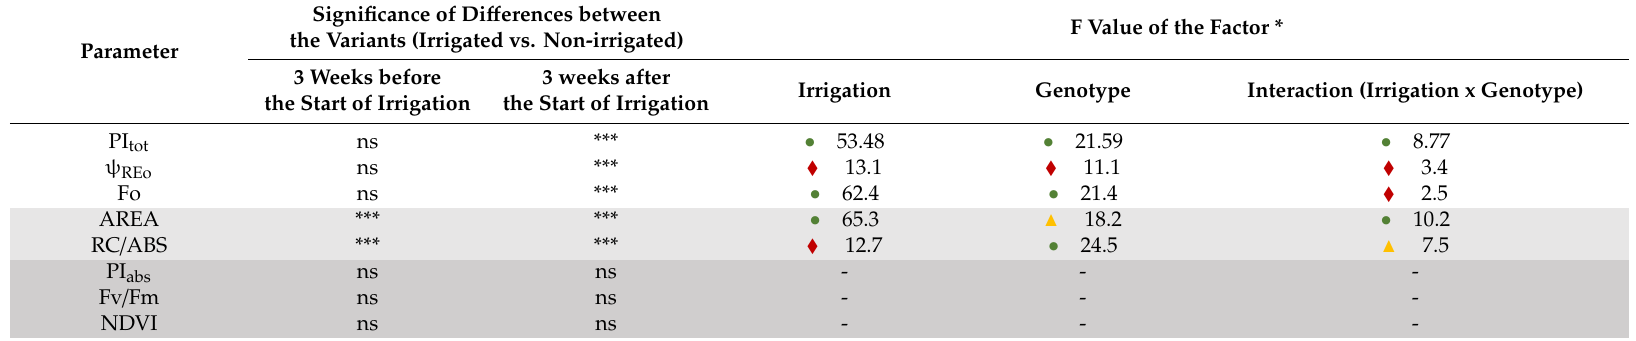
Table 3. Statistical assessment of the factor e ff ects before and after irrigation was